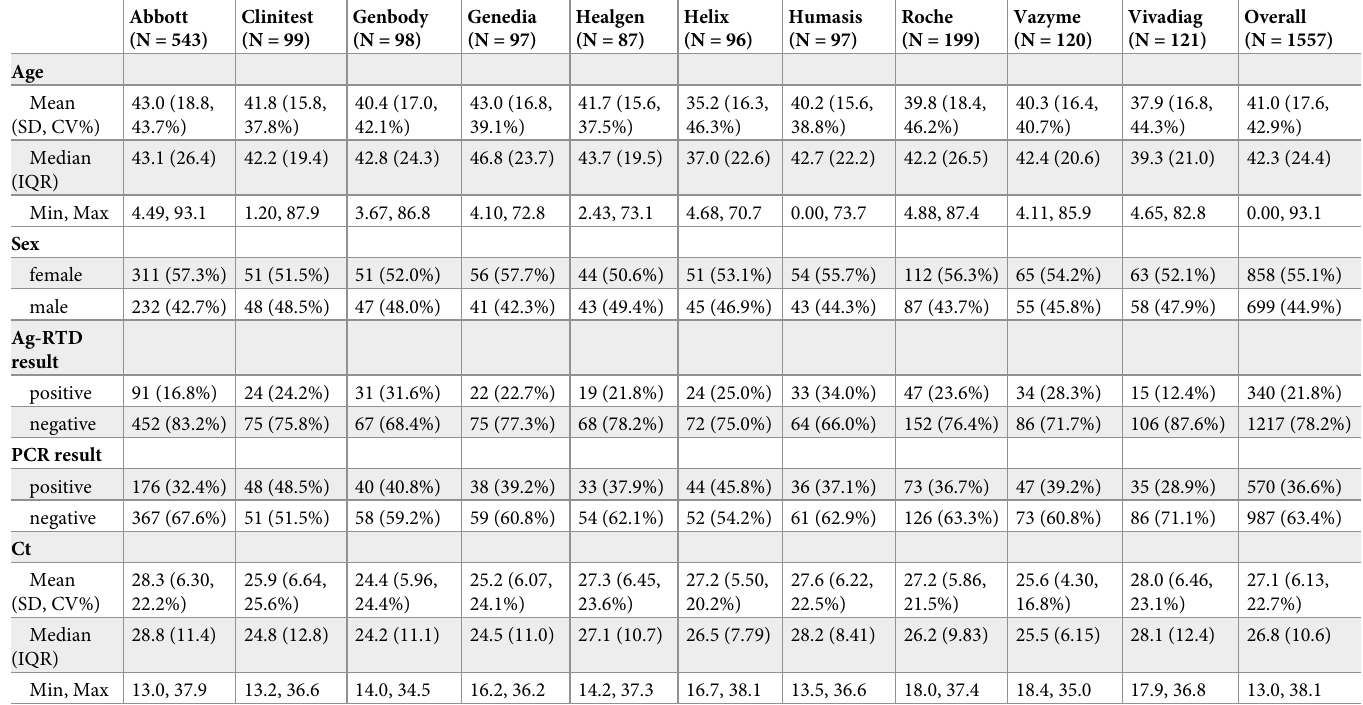
Table 2. Age and gender distriubion in the study group and the number of Ag-RTD and RT-qPCR positive and negative